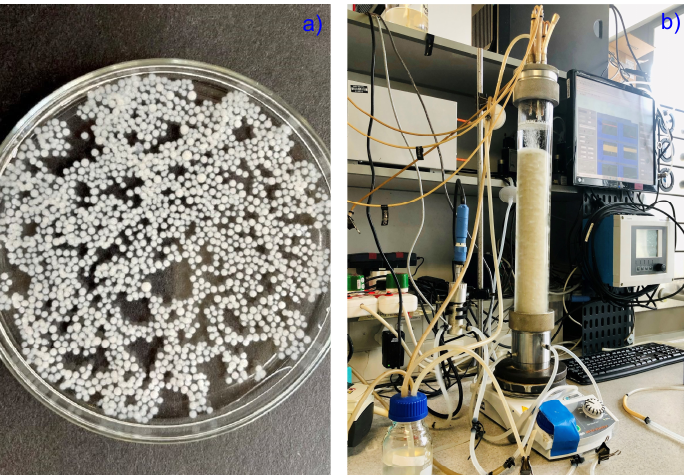
Figure 1. Cell morphology of R. delemar at the end of growth phase in ( a ) shake flask cultivations and ( b ) immobilised reactor cultivations. Pellets in shake flask seed cultures were incubated at 34 °C, pH 5, 200 RPM, and 24 h growth duration, resulting in pellets with 0.9 mm diameter. The growth phase in the immobilised reactor was conducted at pH 5 and 35 °C. The biofilm that resulted had a thickness of 1 ∼